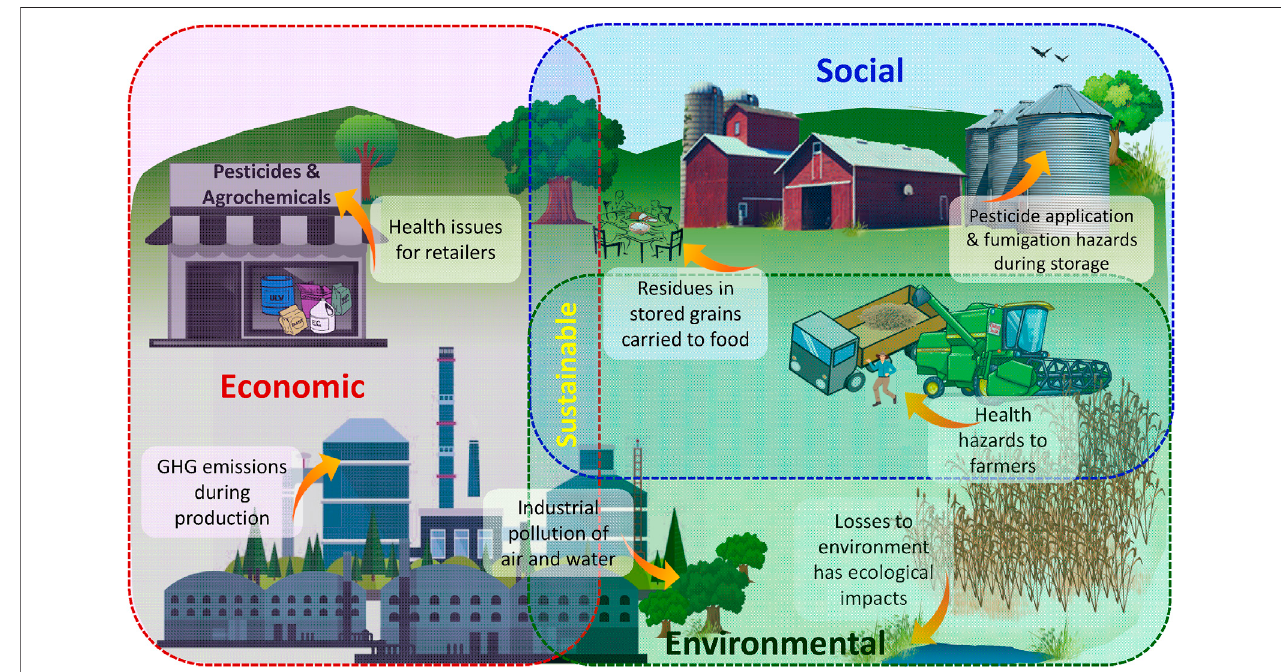
FIGURE 1 | Economic, social, and environmental aspects of sustainability of pesticide use in agriculture.